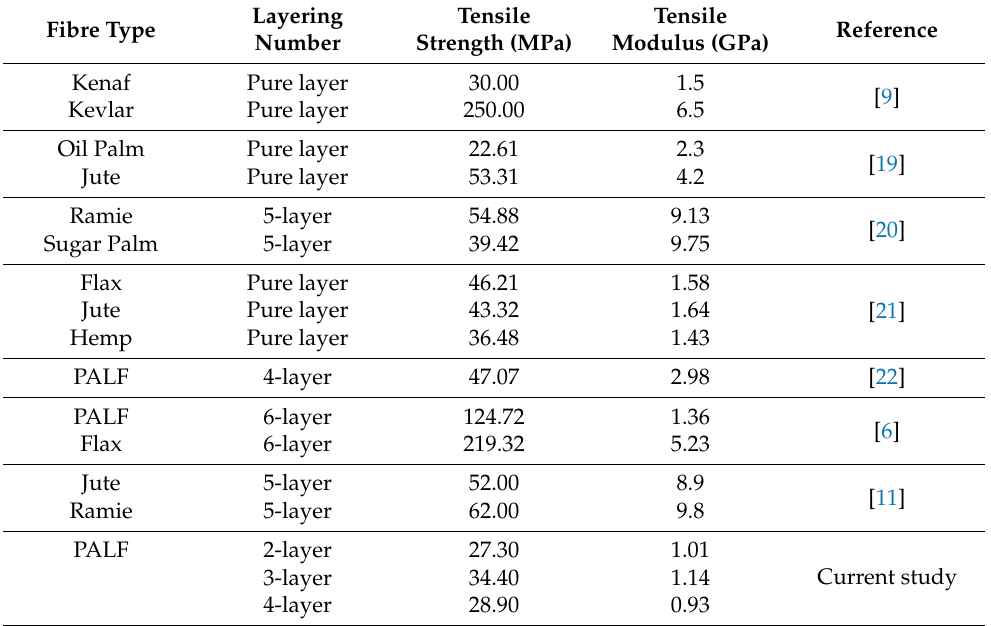
Table 2. Results of previous studies on the tensile properties of fibre-reinforced epoxy composites at different layering